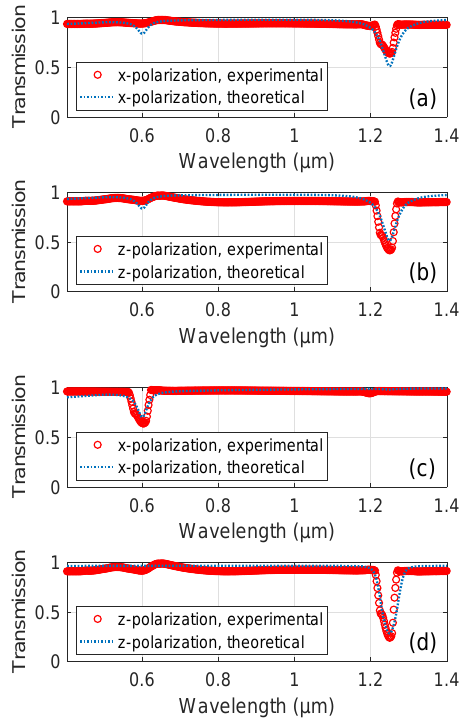
Figure 4. Comparison of experimental (red circles) and theoretical (blue dots) transmissions through a slab of LMC as a function of wavelength at ( a ) 0 V, x -polarization, ( b ) 0 V, z -polarization, ( c ) 60 V, x -polarization, and ( d ) 60 V, z